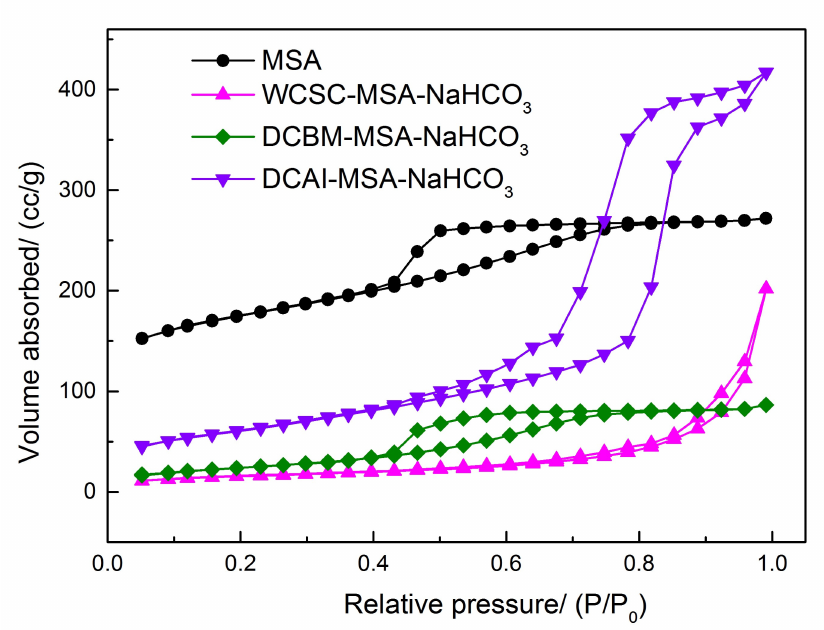
Figure 5. The nitrogen adsorption–desorption results of composite powder explosion